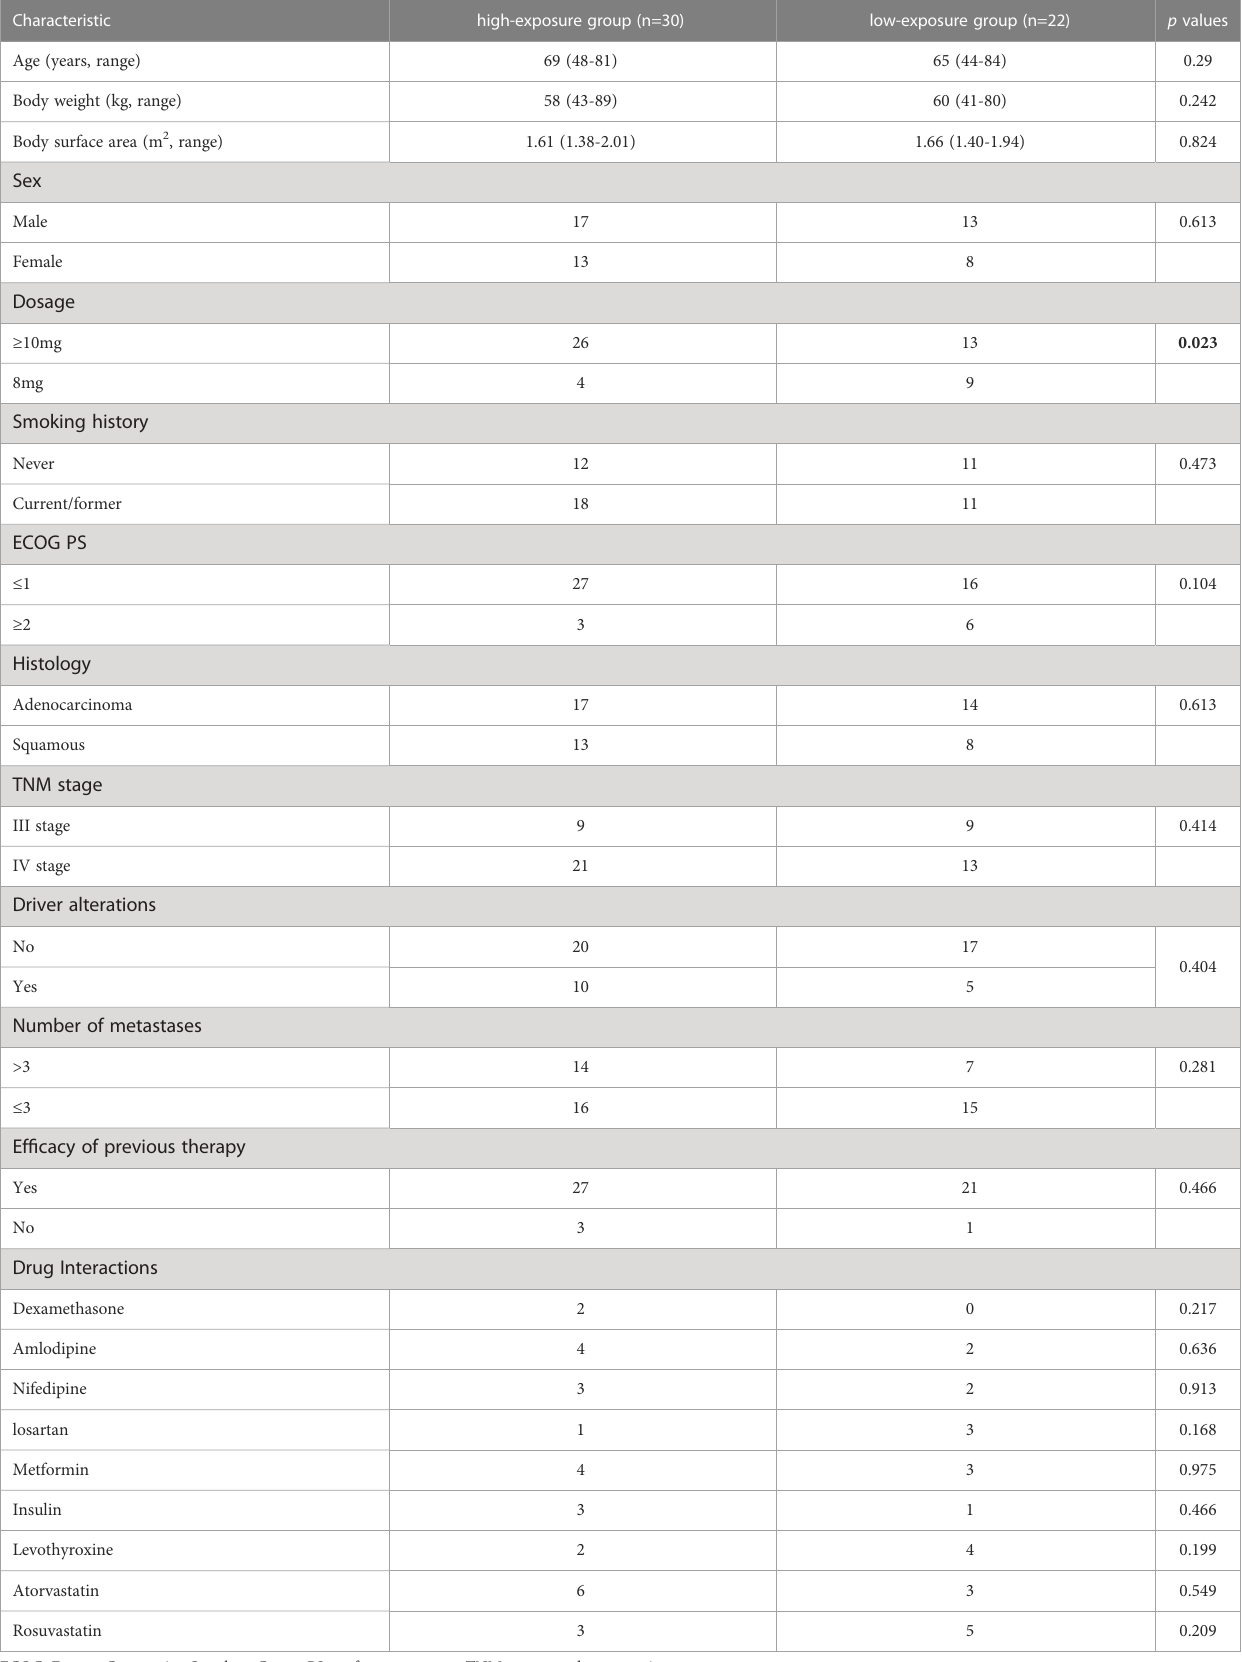
TABLE 2 Comparison between patients with ANL C trough ≥ 10.29ng/ml (high-exposure group) and <10.29ng/ml (low-exposure